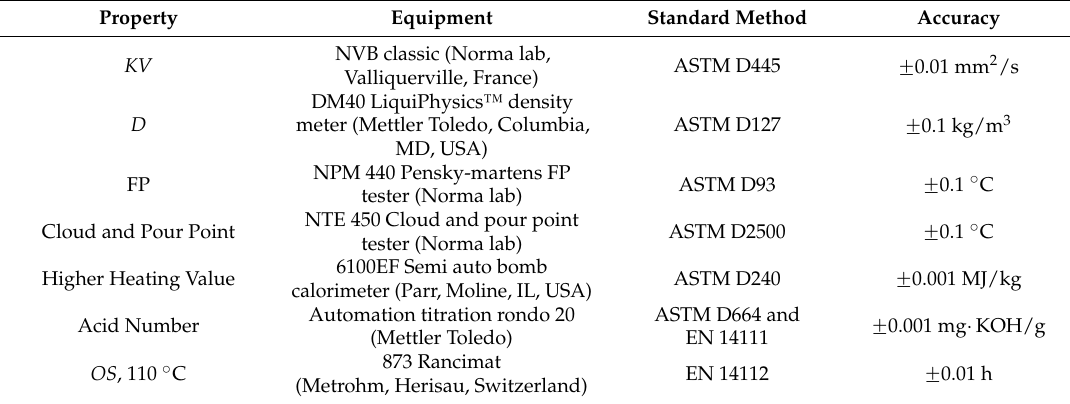
Table 1. List of equipment used in this study. OS : oxidation stability; KV : kinematic viscosity; D : density; FP: flash